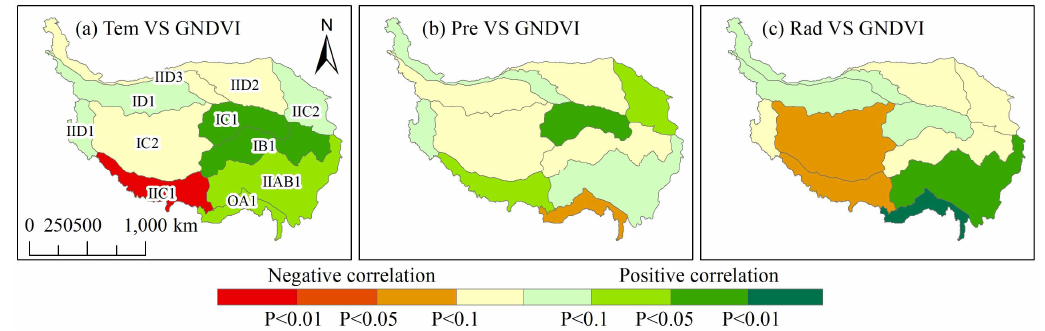
Figure 6. The responses of the GNDVI to temperature (Tem), total precipitation (Pre), and radiation (Rad) within different ecosystem zones during 2000–2015 considering time-lag effects (according to Figure 5). ( a ) The partial correlation between GNDVI and temperature (Tem) after controlling for total precipitation (Pre) and radiation (Rad); and ( b ) the partial correlation between GNDVI and total precipitation (Pre) after controlling for temperature (Tem) and radiation (Rad); ( c ) the partial correlation between GNDVI and radiation (Rad) after controlling for temperature (Tem) and total precipitation (Pre). The significance level for partial correlation was calculated by F